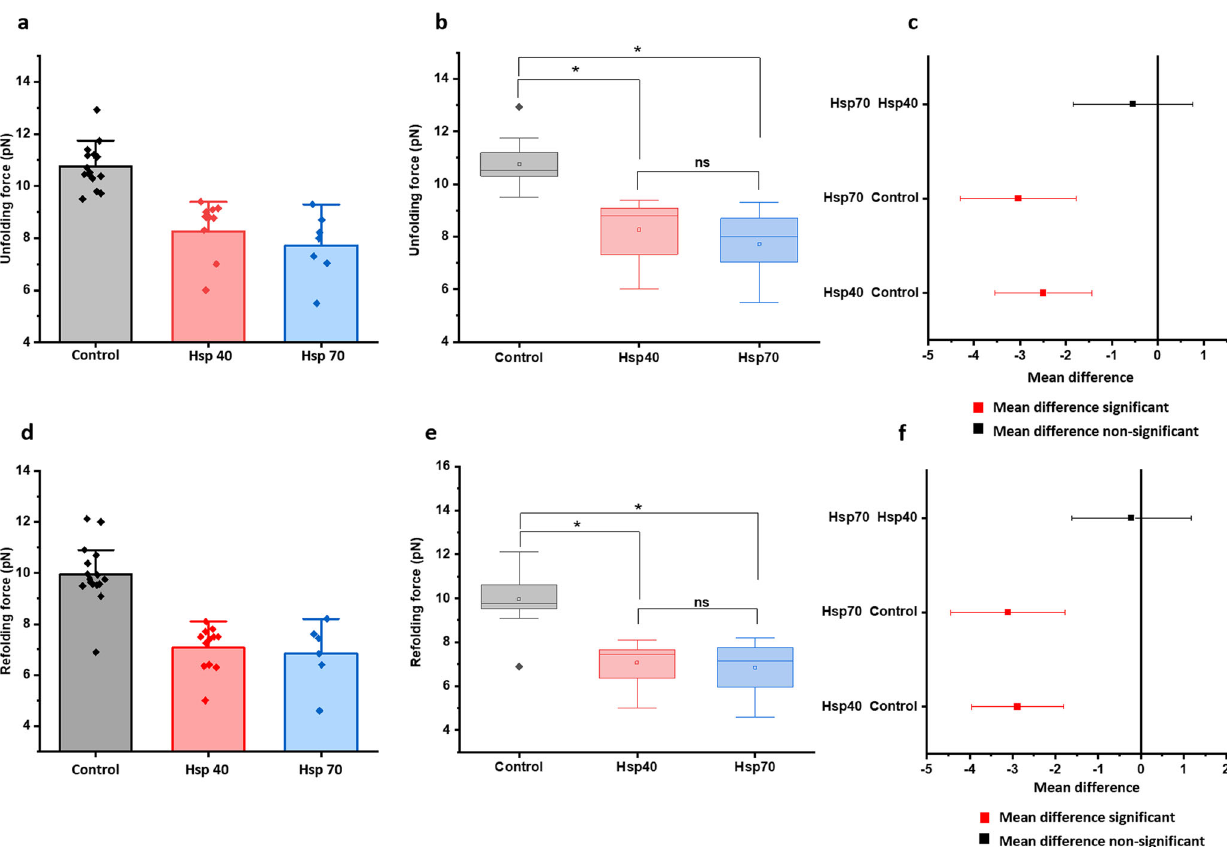
Fig. 5 Mechanical stability of talin with Hsp40 and Hsp70. Hsp70 and Hsp40 chaperones decrease the mechanical stability of talin by changing their unfolding and refolding force. a Unfolding force measured with Hsp70 and Hsp40. In the absence of any chaperones (control), the unfolding force of talin is 10.8 ± 0.2 pN, which has been observed to decrease to 8.3 ± 0.4 pN and 7.7 ± 0.5 pN with Hsp40 and hsp70, respectively. Data points are measured using more than fi ve individual molecules with more than 12 unfolding events. Error bars represent the standard error of the mean (s.e.m.). d Refolding force measured with Hsp70 and Hsp40. Similarly, the refolding force has been observed to shift from 10 ± 0.3 pN (control) to 7 ± 0.5 and 6.8 ± 0.6 pN with Hsp40 and Hsp70, respectively. Data points are measured by averaging a minimum of three molecules. Error bars are represented as s.e.m. ANOVA analysis of b , c unfolding force, and e , f refolding force have been performed to check the statistical signi fi cance of the force data sets with Hsp40 and Hsp70 chaperones, followed by their pair comparison by Bonferroni post hoc test at * p ≤ 0.05 level. It has been observed that both the unfolding and refolding forces are signi fi cantly lower than that of control. Since Hsp40 and Hsp70 act as unfoldases, their mean force differences are non-signi fi cant. R-sq. = 0.630 for unfolding and 0.662 for refolding. For unfolding force analysis, n = 15 (Control); n = 12 (Hsp40); n = 7 (Hsp70). For refolding force, n = 16 (Control); n = 12 (Hsp40); n =